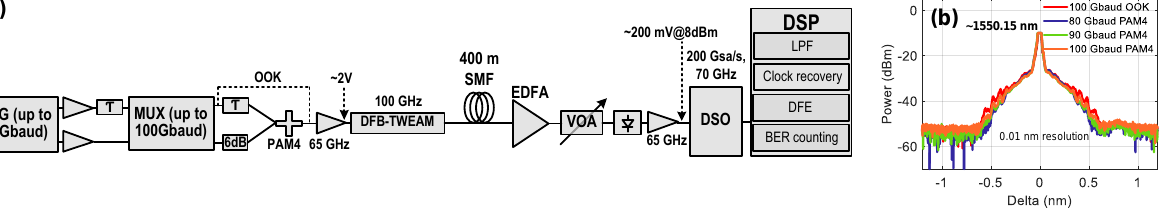
Figure 1. ( a ) Experimental setup (PPG: pulse-pattern generator), ( b ) optical spectra of the 100 Gbaud OOK and PAM4 signals (Mux: multiplexer, Ƭ : delay line, DFB-TWEAM: distributed feedback laser with traveling-wave electroabsorption modulator, SMF: single-mode fiber, EDFA: erbium-doped fiber amplifier, VOA: variable optical attenuator, DSO: digital storage oscilloscope, DSP: digital signal processing, LPF: low-pass filter, DFE: decision feedback equalizer, BER: bit error rate).